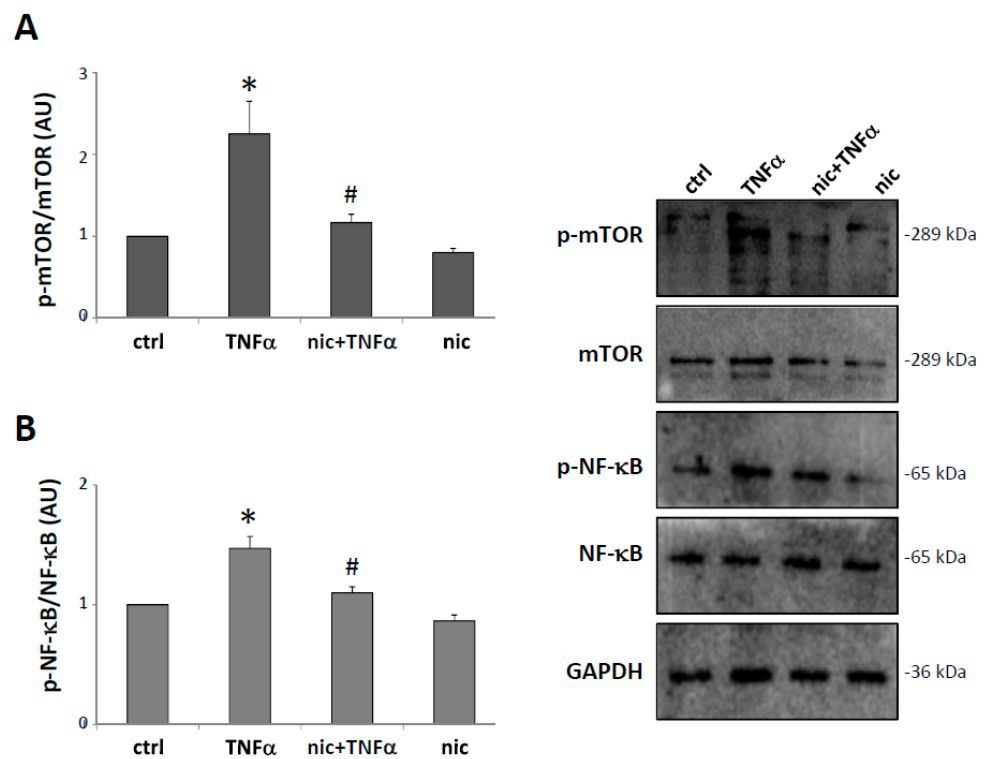
Figure 4. Niclosamide prevents mTOR (mammalian target of rapamycin) and NF- κ B (nuclear factor-kappa B) activation in TNF α -stimulated microglia. Primary microglia were pre-treated with DMSO (ctrl) or 100 nM niclosamide (nic). After 24 h, the cells were stimulated with 50 ng / mL TNF α for 48 h. Protein lysates were analyzed by western blot using anti-phospho-mTOR and anti-mTOR ( A ) or anti-phospho-NF- κ B and anti-NF- κ B ( B ). Anti-GAPDH was used for protein normalization. Quantification of protein bands relative to the control is expressed in an arbitrary unit (AU). Data are reported as mean ± S.E.M. (n = 3 independent experiments). Statistical significance was calculated by ANOVA followed by Post Hoc Tukey’s test. * p < 0.05 relative to control, # p < 0.05 relative to TNF α -treated cells.